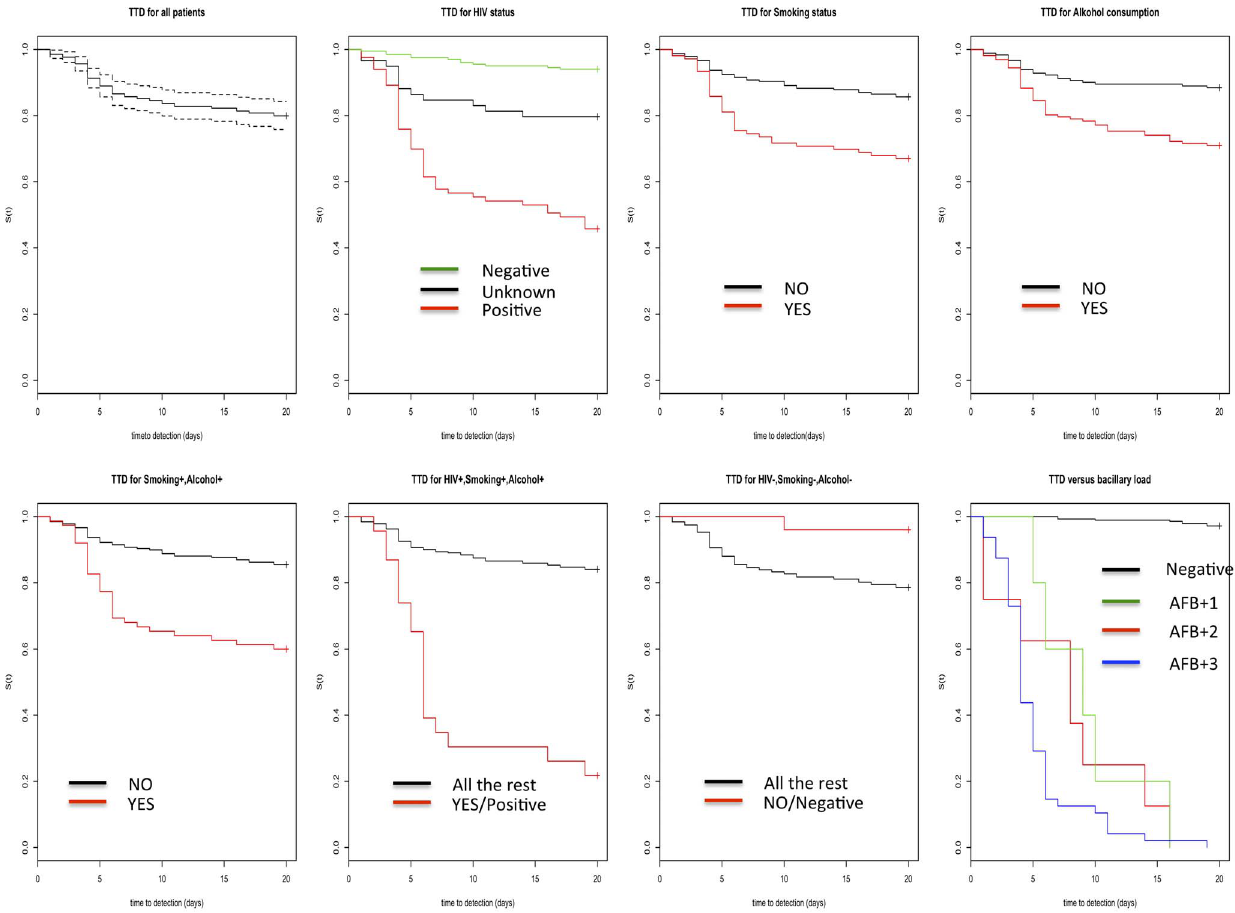
Figure 2. Kaplan-Meier plots showing the Time to detection (TTD) of bacilli on MGIT960 (Y-axis=s(t) which is the survival function, X-axis is the TTD in days). Top row first graph shows the time to detection of all the 344 patients without any covariate structure considered. Second, third and fourth show the TTD when HIV status, Smoking and alcohol consumption are considered as covariates respectively. Bottom row: The first, second, third and fourth graph show the TTD for the combination of (patients who consume alcohol and smoke), (patients who smoke, consume alcohol and are HIV positive), (HIV negative patients who neither consume alcohol nor smoke) and bacillary load levels respectively.